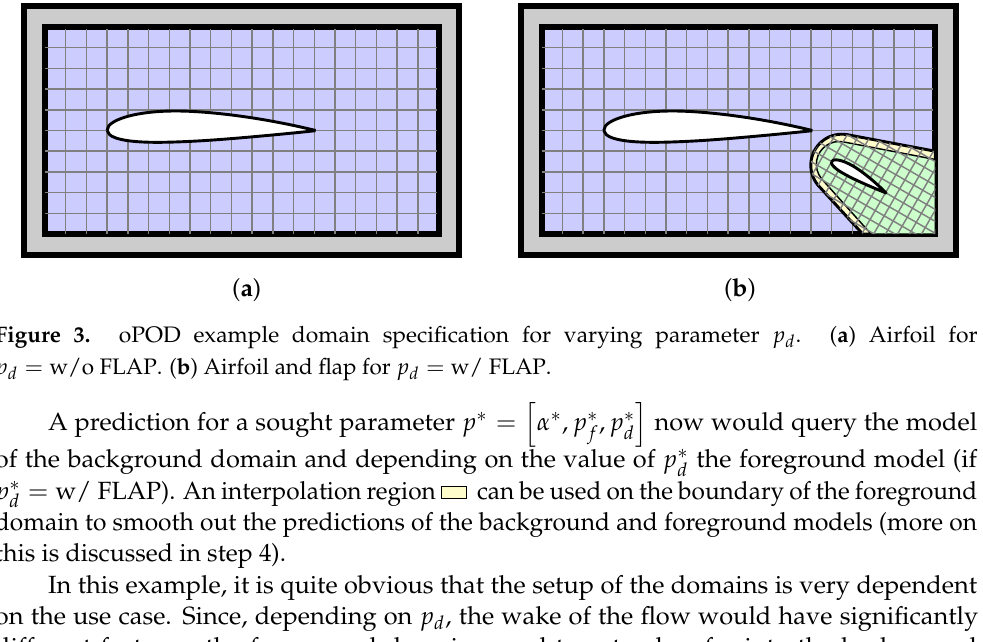
d . ( a ) Airfoil for